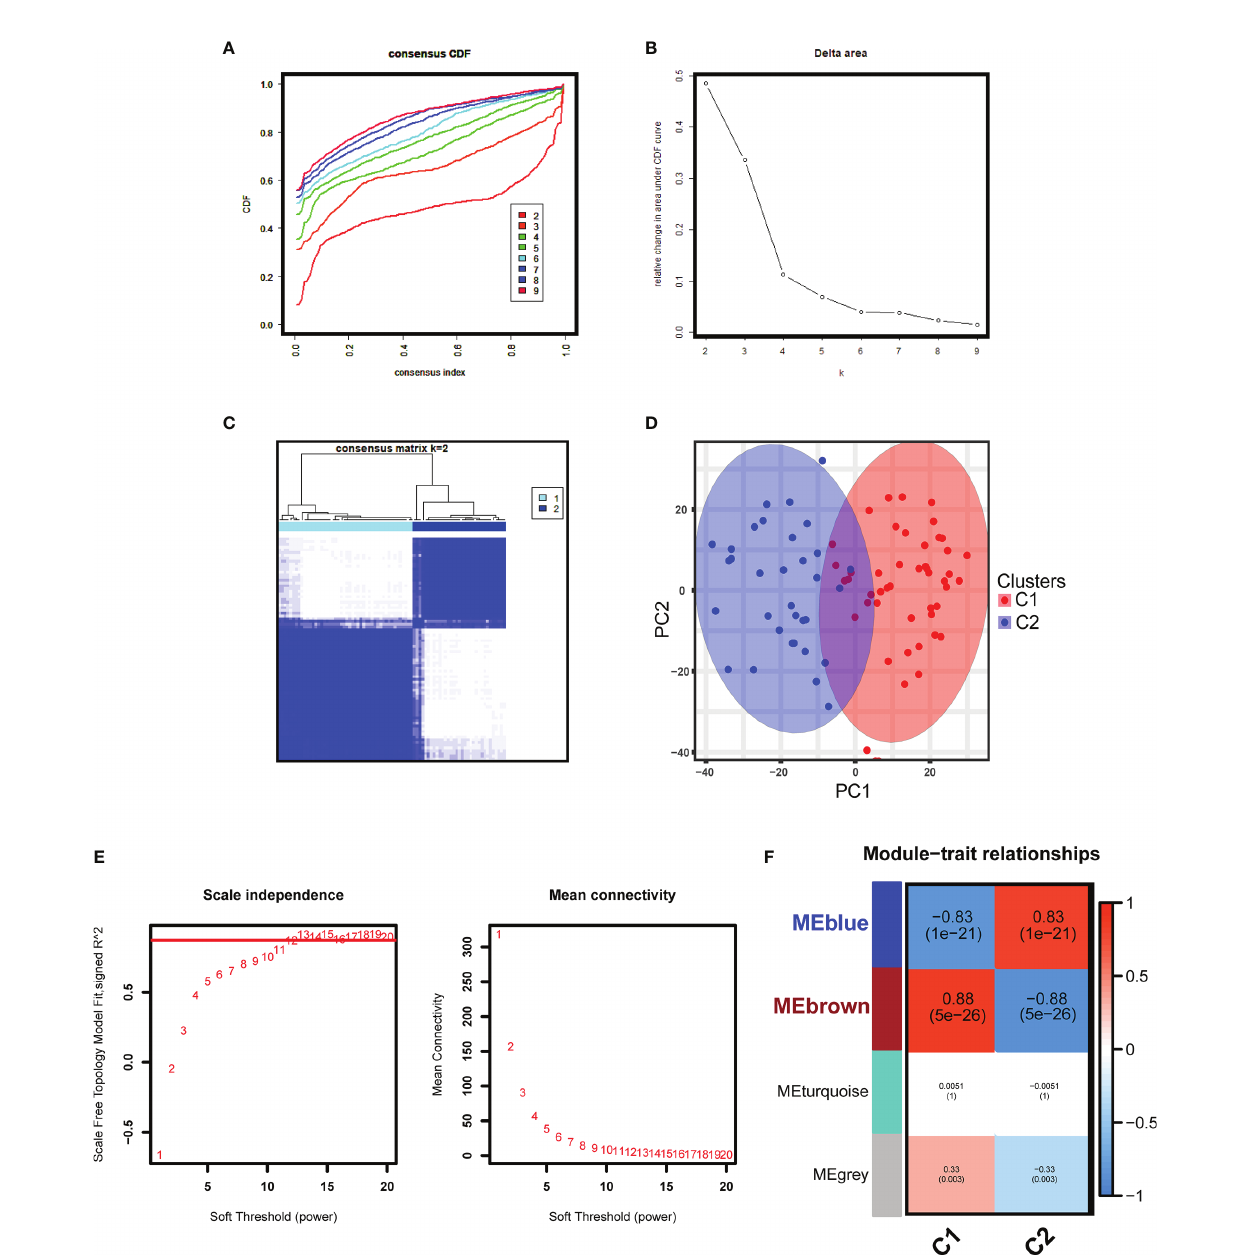
FIGURE 2 | Unsupervised consensus clustering and WGCNA analyses in the GDN training cohort. (A) Cumulative distributive function (CDF) for k = 2 to 9. (B) Delta diagram showing the variations of the area under the consensus clustering CDF curve for k = 2 to 9. (C) Heatmap exhibiting the two clusters of DN samples with k = 2. (D) The principal component analysis (PCA) based on the results of consensus clustering analysis. (E) Analysis of the network topology for various soft-threshold powers. (F) Heatmap displaying the module-trait